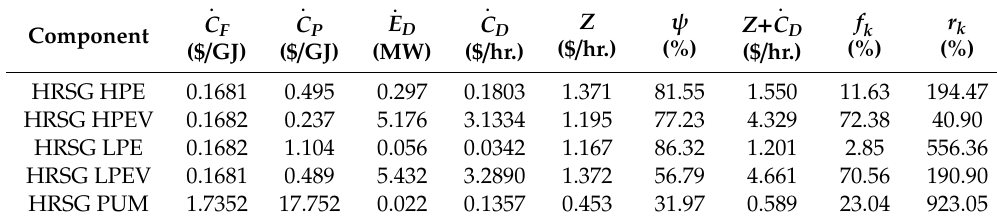
Table 7. Exergoeconomic parameters for the heat regenerative steam generator (HRSG).